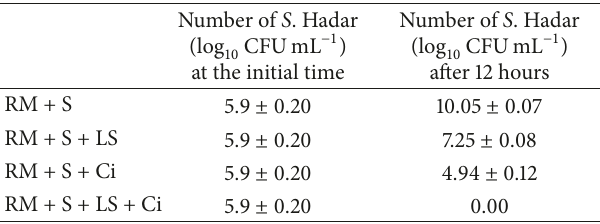
Table 2: Efficacy of the lactoperoxidase system and cinnamon essential oil in inhibiting the growth of Salmonella enterica Hadar. Number of S . Hadar Number of S . Hadar (log 10 CFUmL −1 ) (log 10 CFU mL −1 ) at the initial time after 12 hours RM + S 5.9 ± 0.20 10.05 ± 0.07 RM + S + LS 5.9 ± 0.20 7.25 ± 0.08 RM + S + Ci 5.9 ± 0.20 4.94 ± 0.12 RM + S + LS + Ci 5.9 ± 0.20 0.00